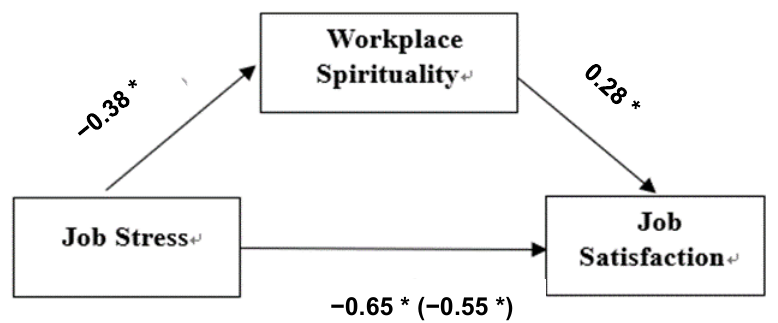
Figure 2. Mediating e ff ect of workplace spirituality on the relation between job stress and job satisfaction. * p < 0.001, ** p <